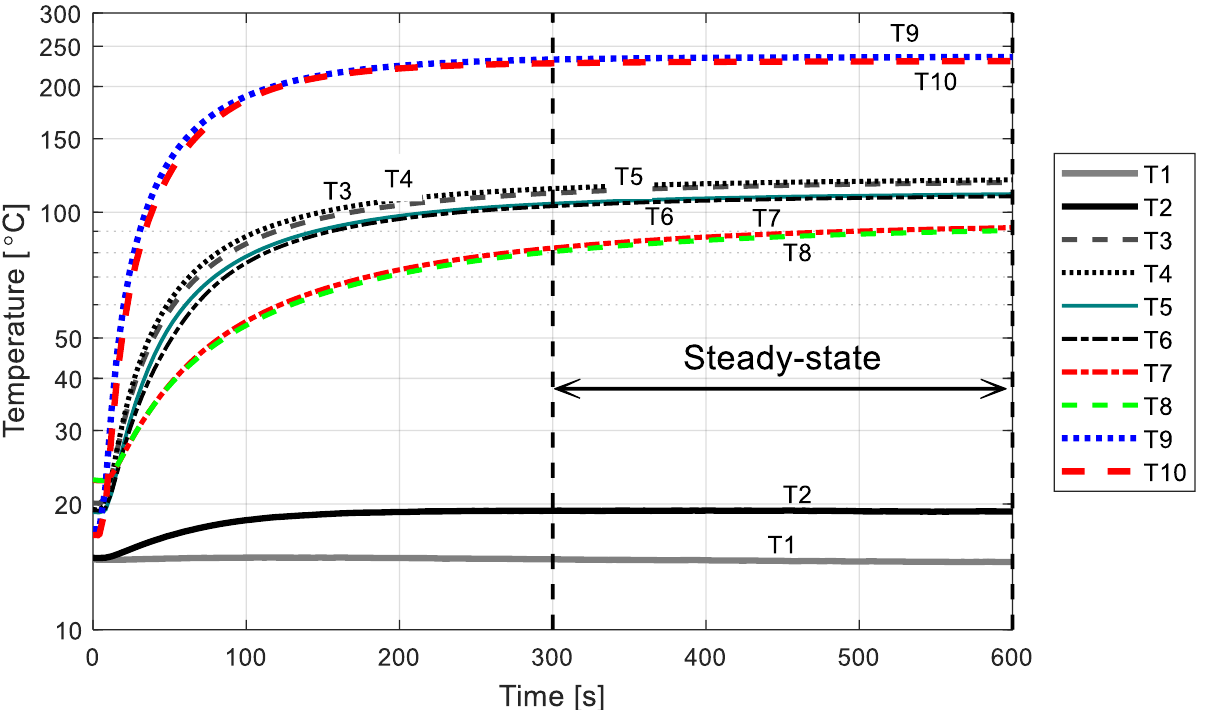
Figure 7. Temperature-time evolution during the heating phase, for the input power level of 400 W.